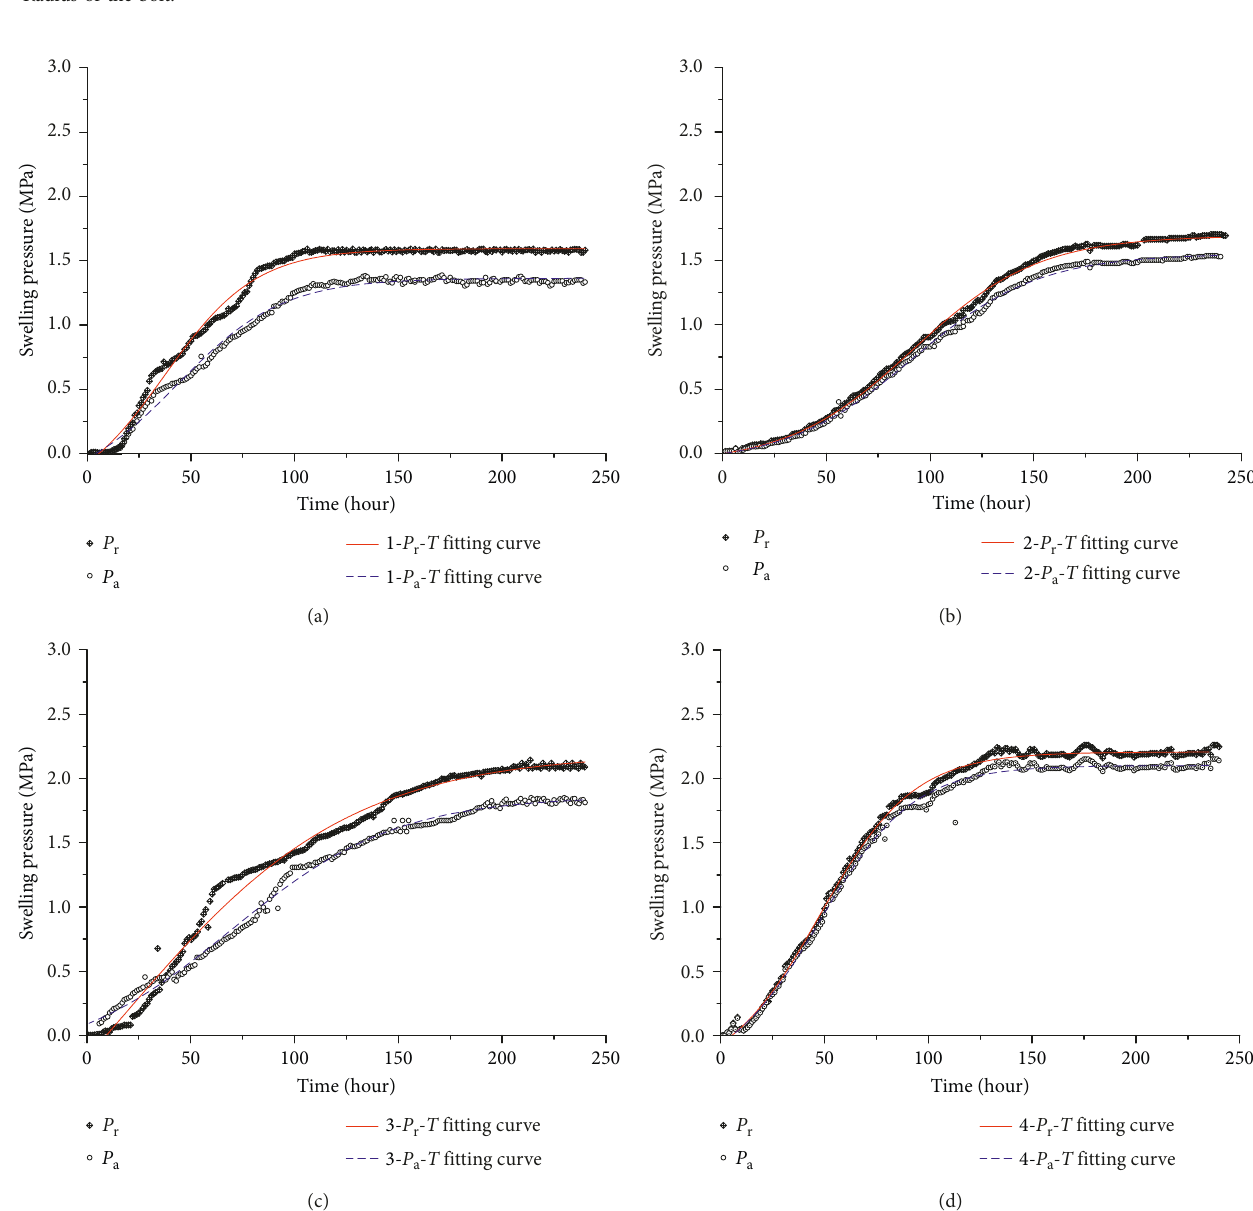
Figure 4: Variations of swelling pressure over time: (a) radial and axial swelling pressures-time curves in test no. 1; (b) radial and axial swelling pressures-time curves in test no. 2; (c) radial and axial swelling pressures-time curves in test no. 3; (d) radial and axial swelling pressures-time curves in test no. 4.